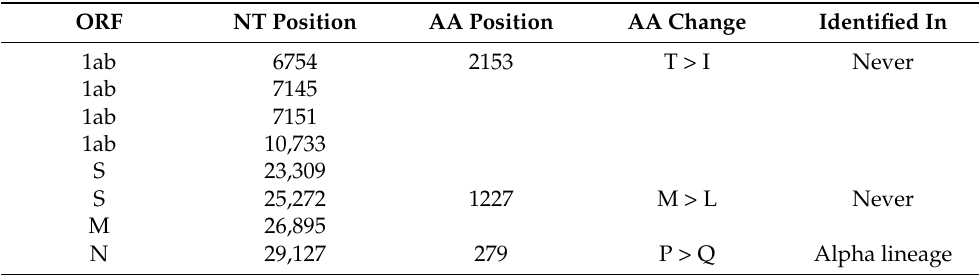
Table 2. Consensus changes in hCoV-19/dog/USA/KS-8074/2021 (GISAID # EPI_ISL_4253995) as compared to the closest reference hCoV-19/USA/KS-KSU-2046/2021 (GISAID# EPI_ISL_3693315). Nucleotide (NT) and amino acid (AA) changes were identified in ORF 1ab, the spike (S), the matrix (M), and the nucleocapsid (N) coding region only. AA position denoted only if the AA was changed from the